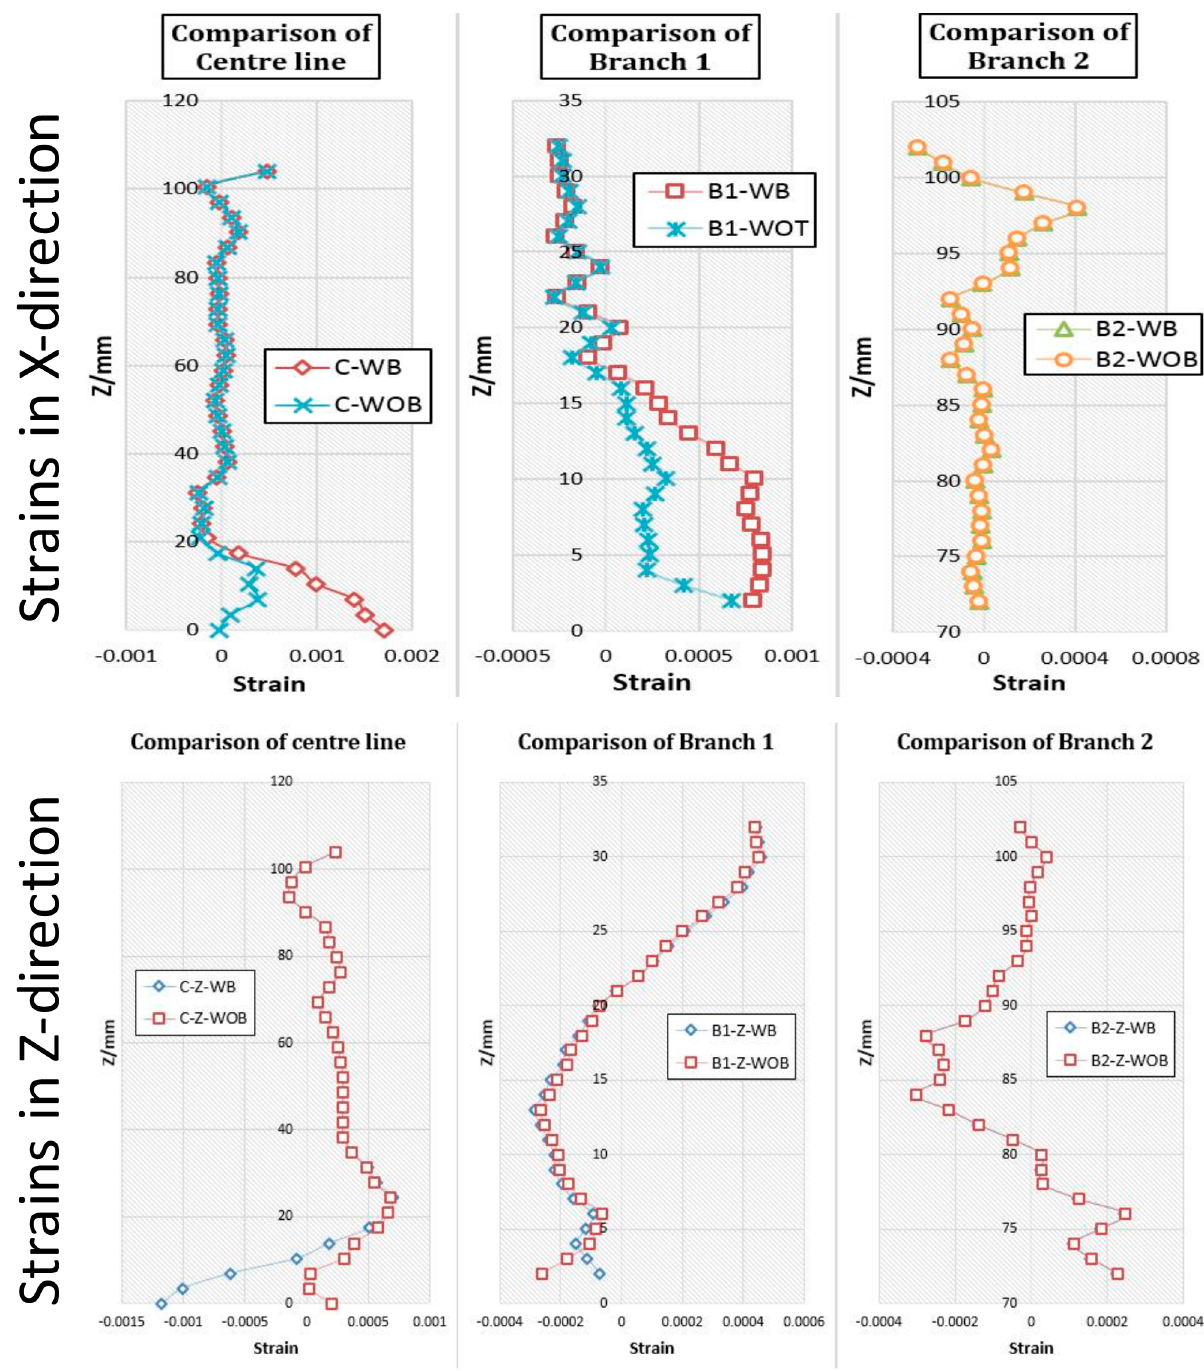
Figure 10. FEA simulation of strain distribution with base (WB) and without the base (WOB).